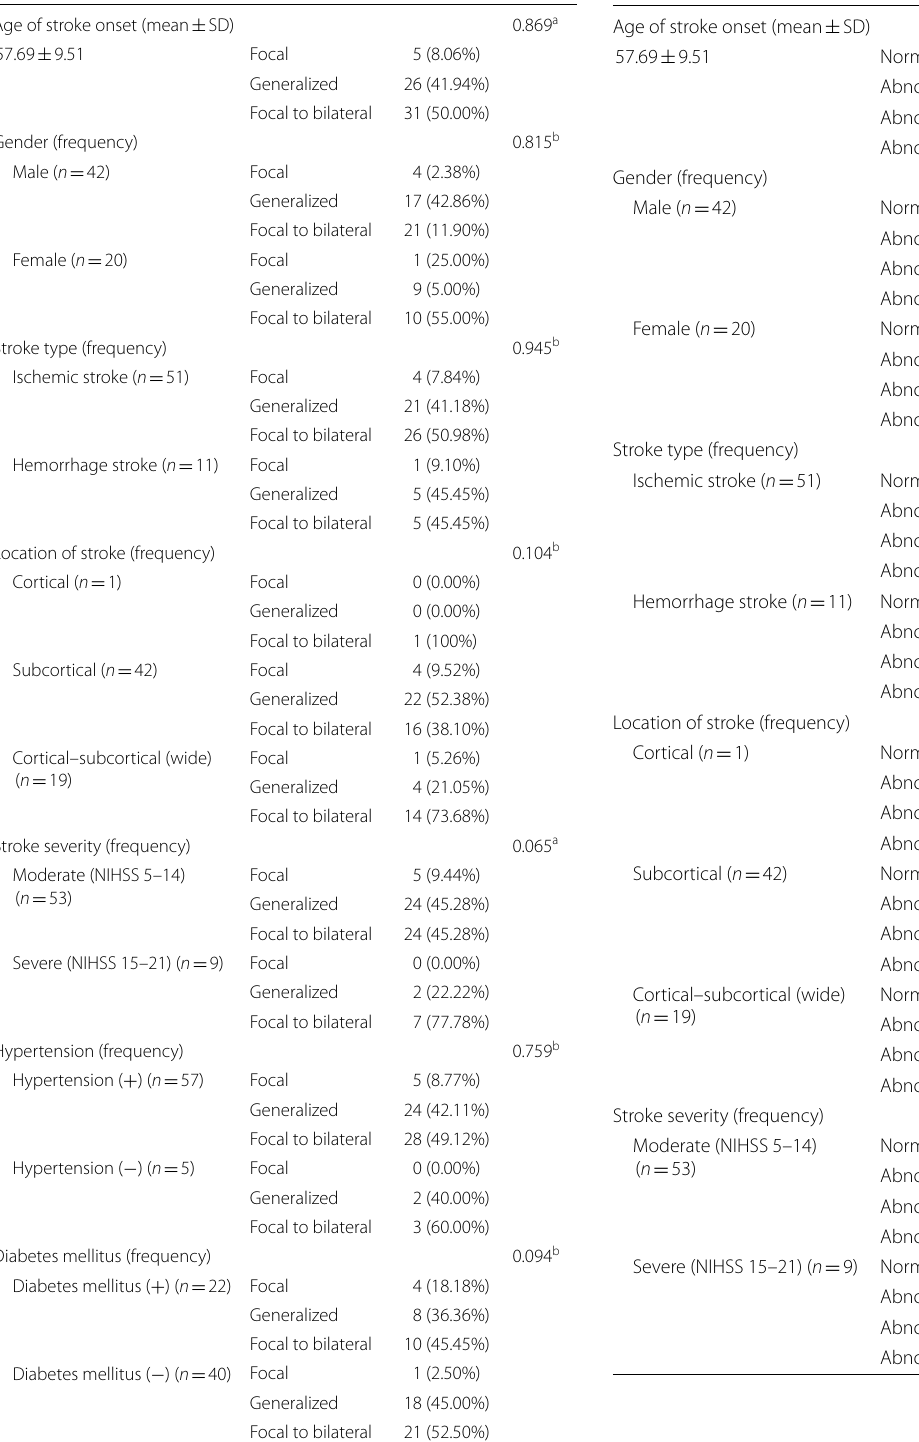
Table 3 Factors analysis related to seizure pattern Table 4 Factors analysis related to EEG